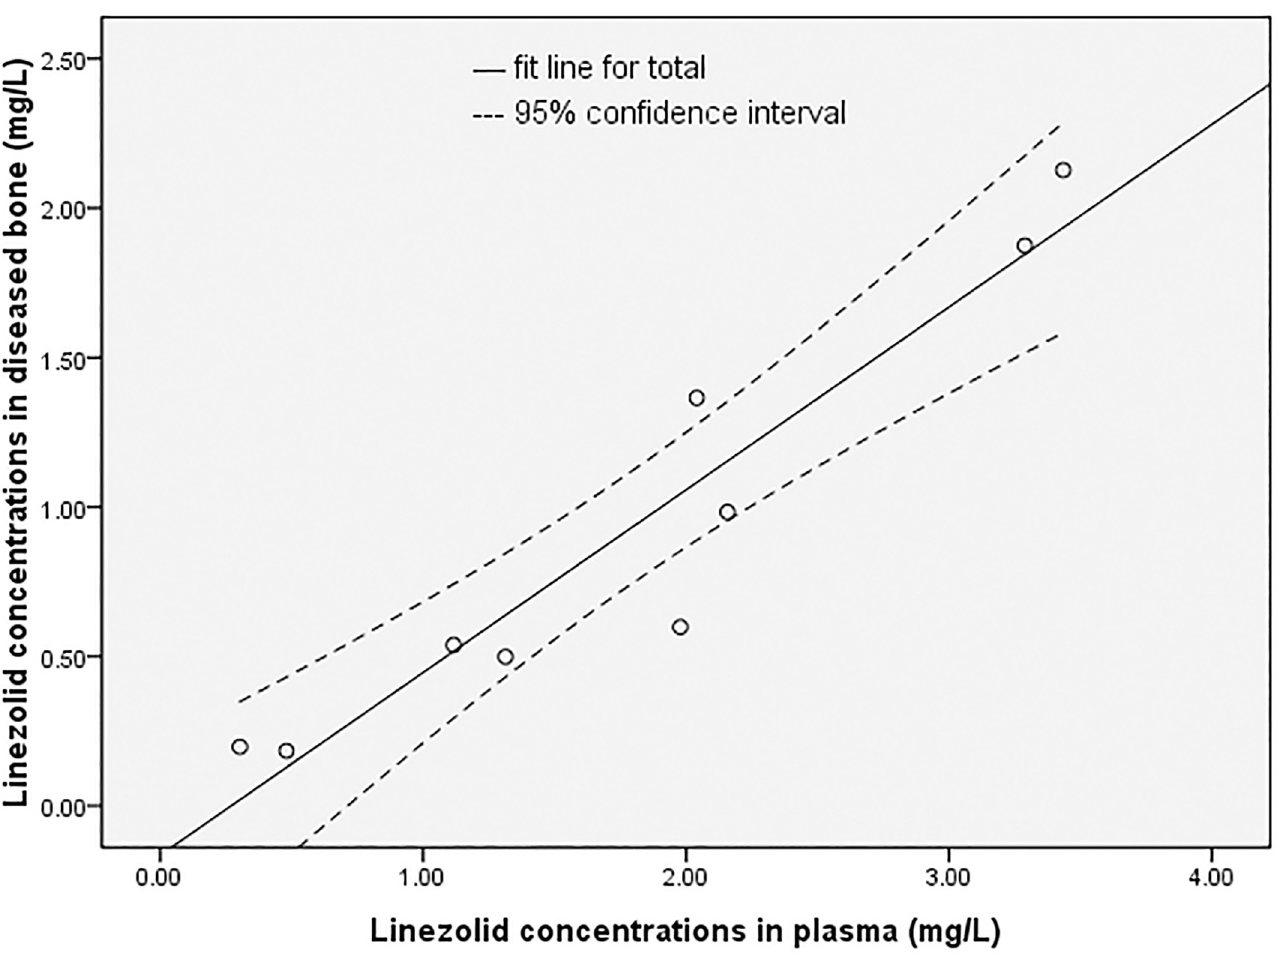
Fig 1. The scatter plot of linezolid concentrations in diseased bone and plasma of 9 patients.